Question: Summarize what this figure shows in one sentence.
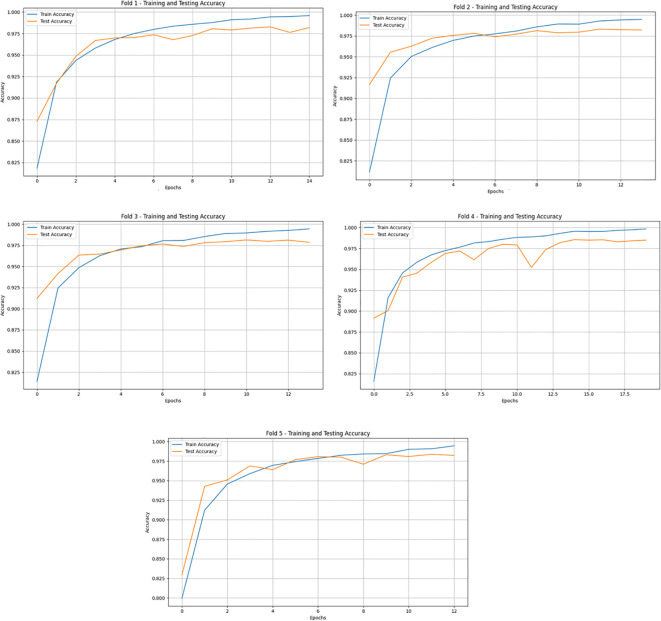
Answer: Accuracy performance of TF model.